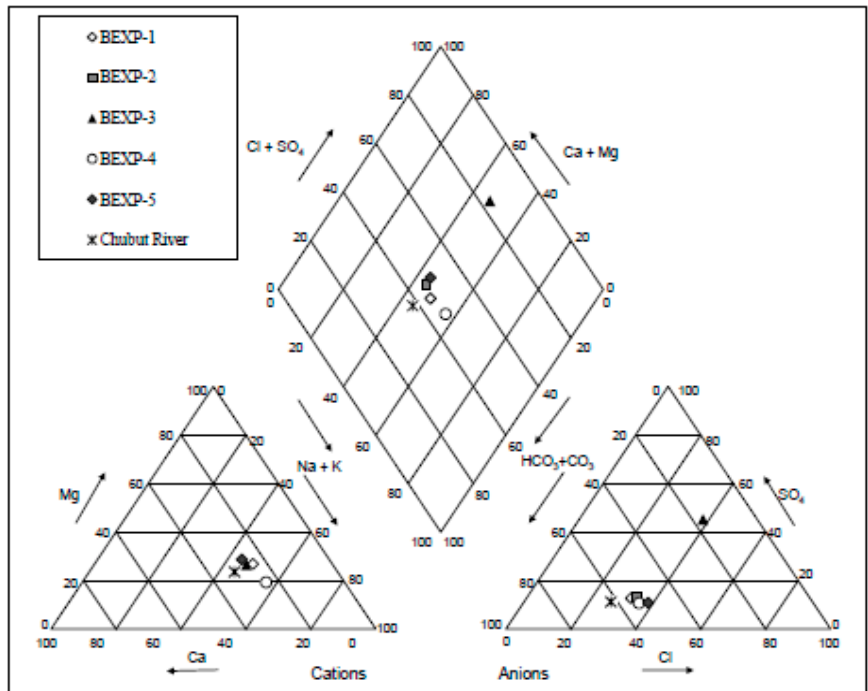
Figure 5. Piper diagrams for cation and anions in groundwater and surface waters.